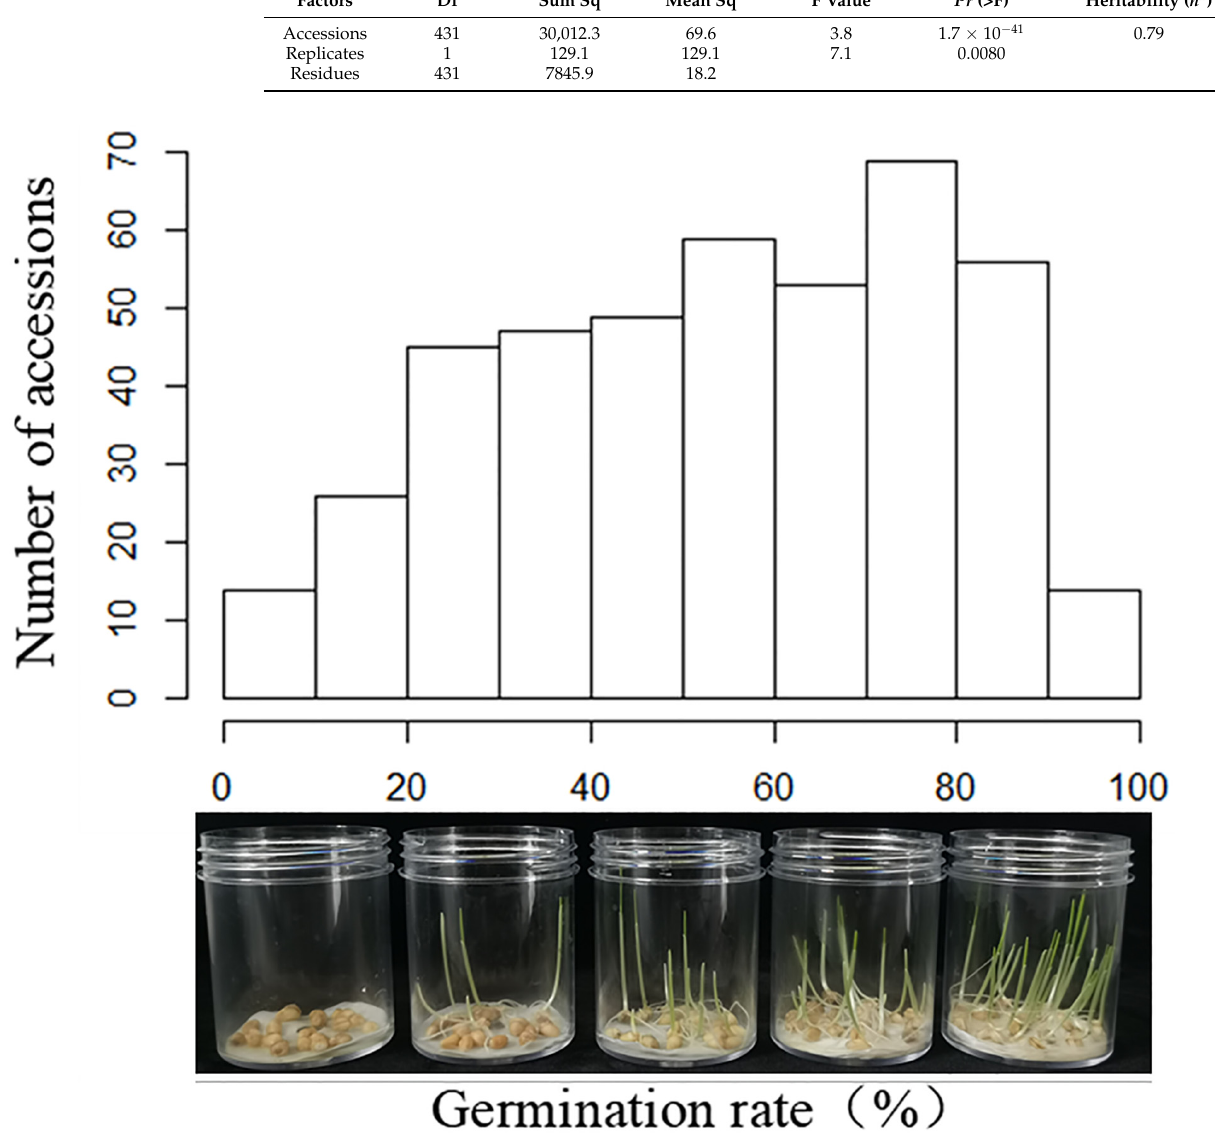
Figure 1. The variation of seed germination rate (SGR) after waterlogging treatment of the 432 wheat varieties. Table 1. The analysis of variance for seed germination rate after waterlogging treatment of the 432 wheat